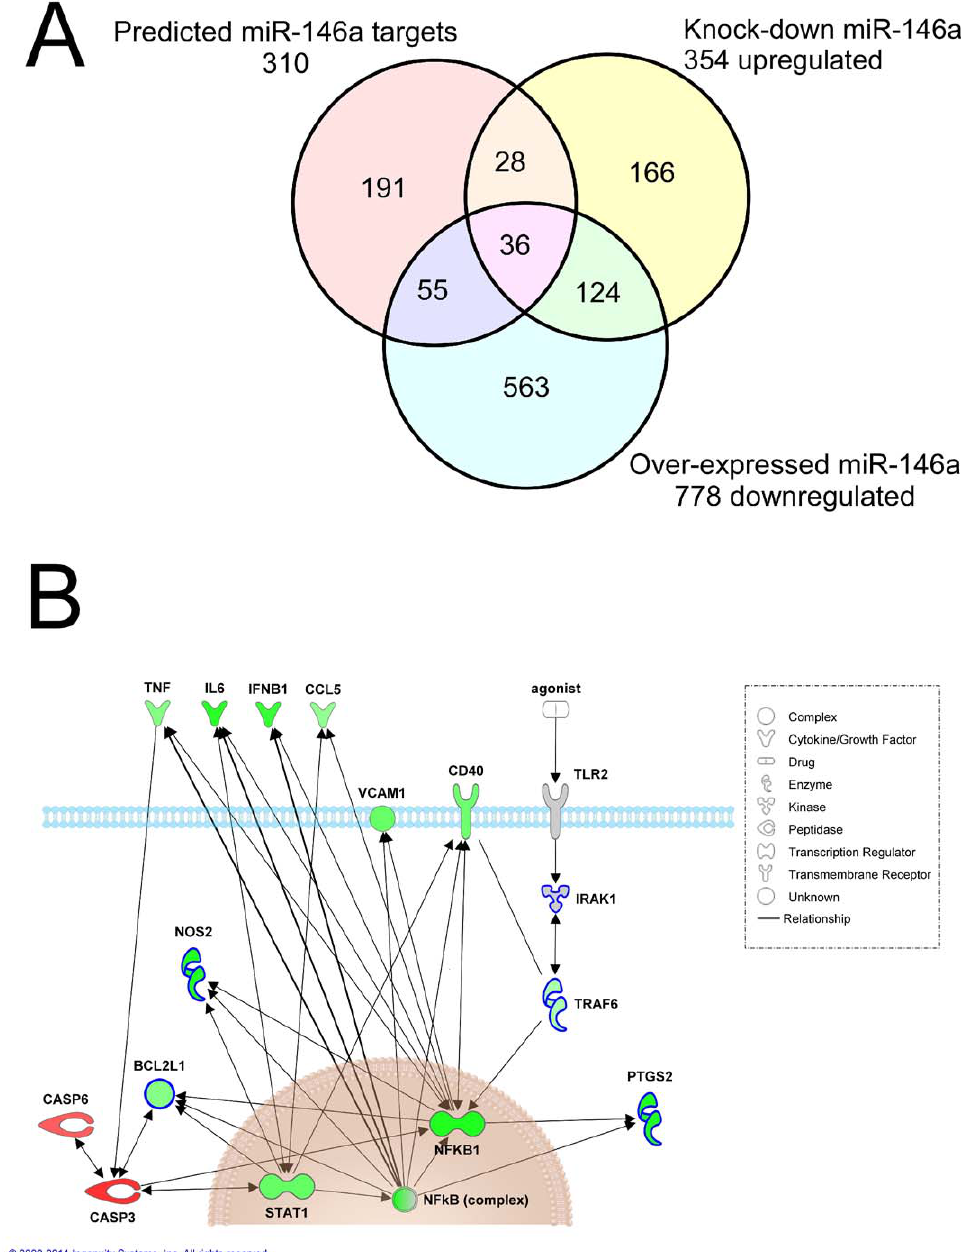
Figure 6. Analysis of genes dysregulated upon over-expression, or knock-down, of miR-146a in stimulated EOC 13.31 cells using either miRNA mimics or anti-miRs. A. Venn diagram to show the intersection between genes down-regulated in LPS stimulated EOC 13.31 cells by miR-146a over-expression, and those up-regulated upon miR-146a knock-down. Also shown are those targets bioinformatically predicted using the TargetScan 5.1 program and IPA software. B. Schematic showing alterations in expression in key inflammatory response-related genes in LPS stimulated EOC 13.31 cells following miR-146a over-expression. Colored green are those down-regulated genes, colored red are up-regulated genes, while those highlighted in blue are bioinformatically predicted targets of miR-146a using the TargetScan 5.1 program and IPA software.